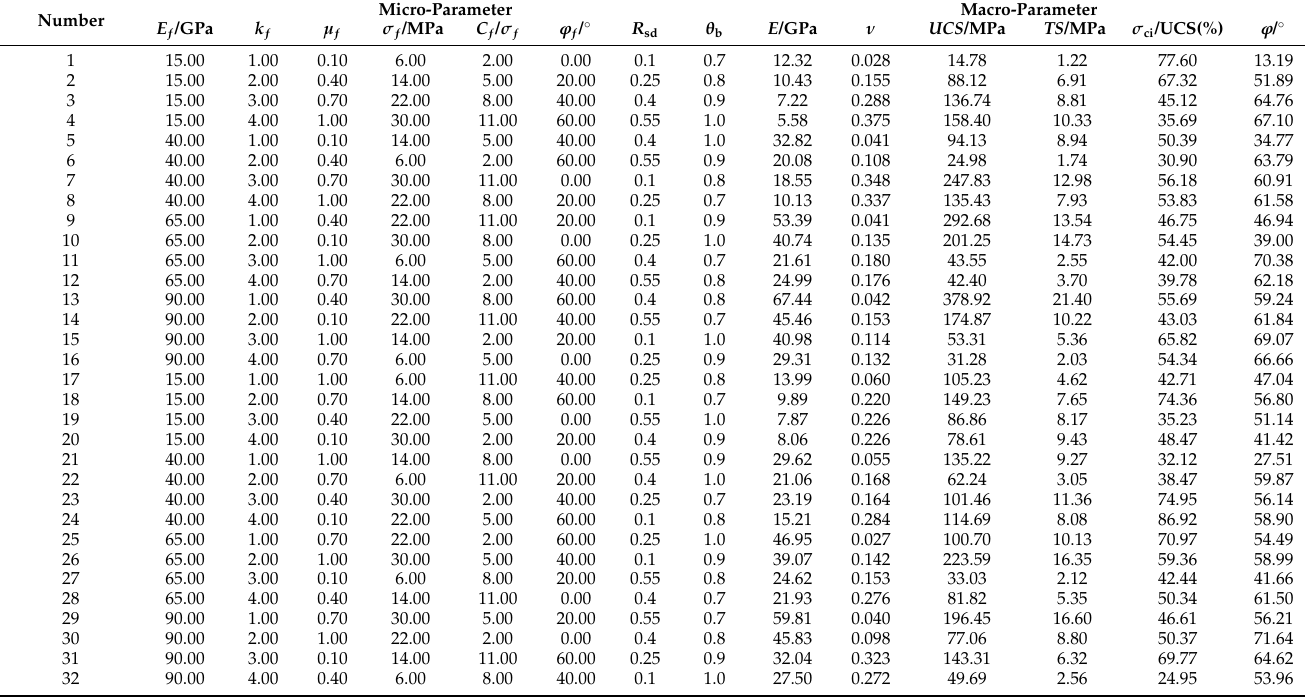
Table 3. Orthogonal numerical test scheme and results.